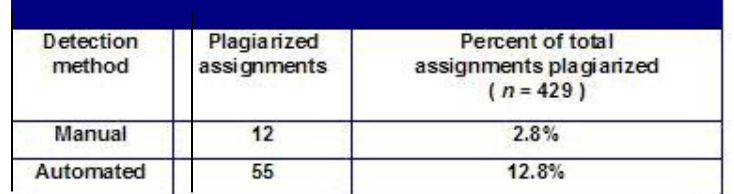
Table 2. Comparison of plagiarism